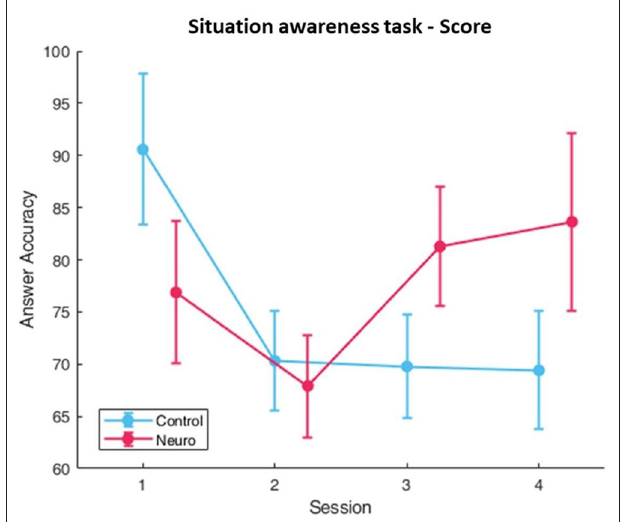
FIGURE 10 | Behavioral performance as measured by the ratio of correct answers. No significant differences or interactions were found (whiskers are SEM).